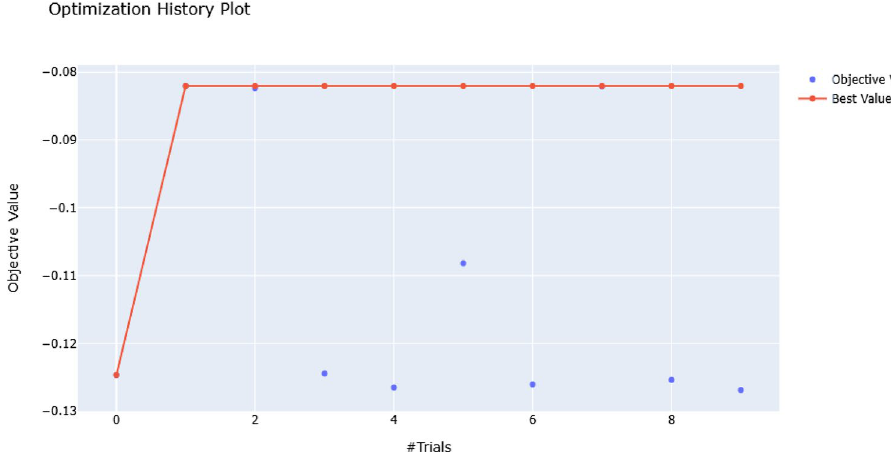
Fig. 10 Optimization